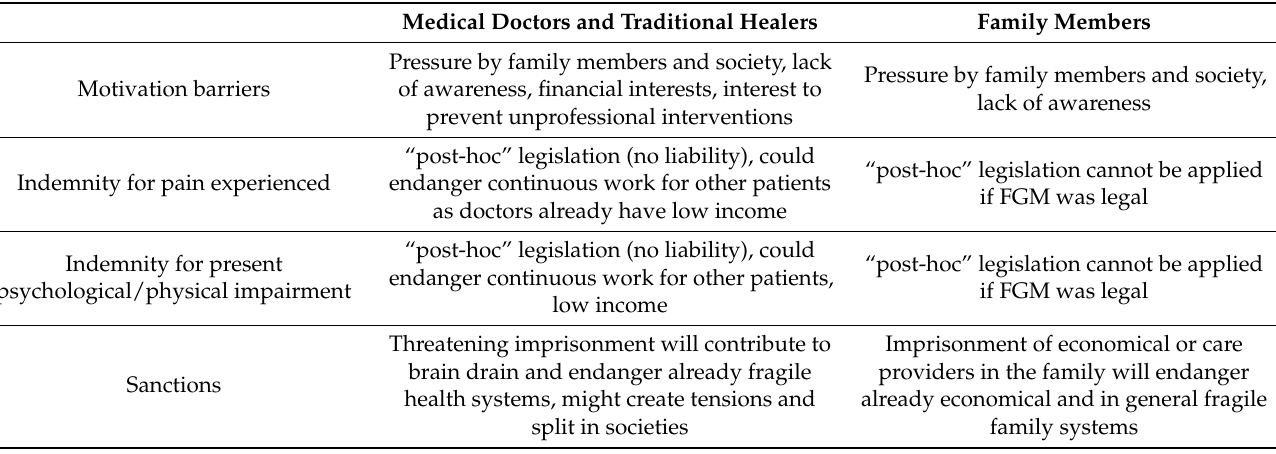
Table 1. Challenges in countries of